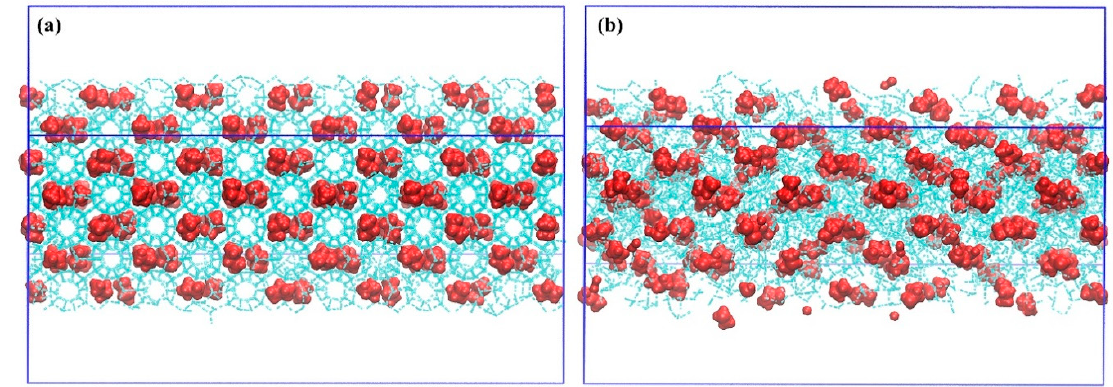
Figure 1. Depiction of incipient rearrangements to facilitate propane-nanobubble growth in non-equilibrium molecular- dynamics (NEMD) simulation in 0.1 V/Å fields: ( a ) initial gas-hydrate configuration, ( b ) early-stage nanobubble coales- cence.